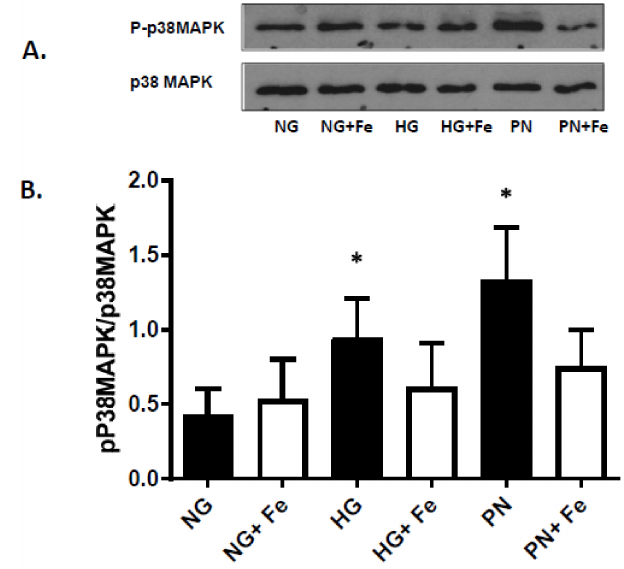
Figure 5. High glucose and peroxynitrite increased p38 MAPK activation that was reversed by FeTTPs. ( A ) Representative Western blot of total and phosphorylated p38 MAPK in lysates of retinal EC cultures treated with normal glucose (NG), high glucose (HG, 25 mM) for 3 days, or peroxynitrite (PN, 0.5 mM) overnight. B. Statistical analysis using two-way ANOVA showed significant impact of apoptotic insult and treatment effect. EC treated with HG or PN caused significant increase in p38 MAPK activation compared to NG. This effect was significantly reduced by co-treatment with FeTTPs (Fe, 2.5 µ M) in HG- or PN-treated cultures. (* p < 0.05, significant using Bonferroni test compared to the rest of the groups, n =